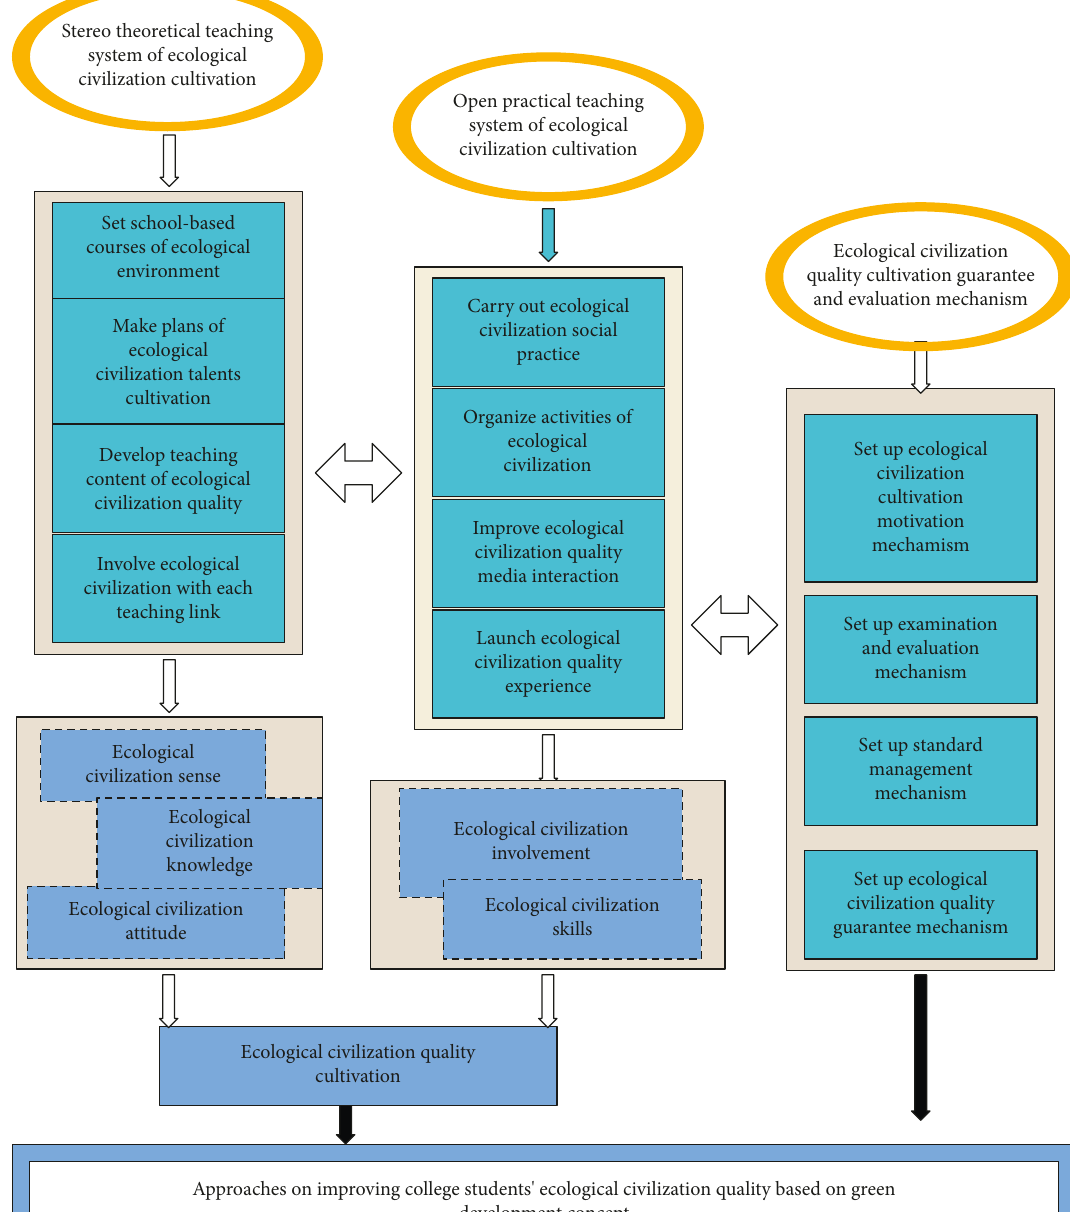
Figure 4: The implementation path for improving the quality of ecological civilization of college